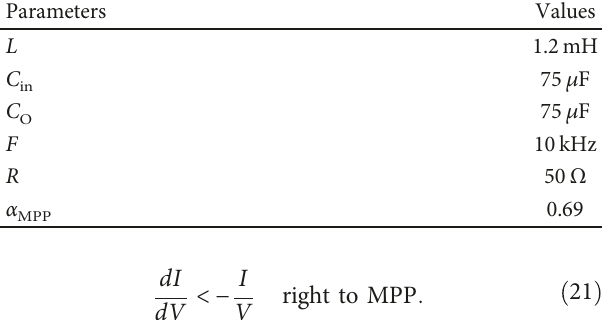
Table 2: Design of the boost